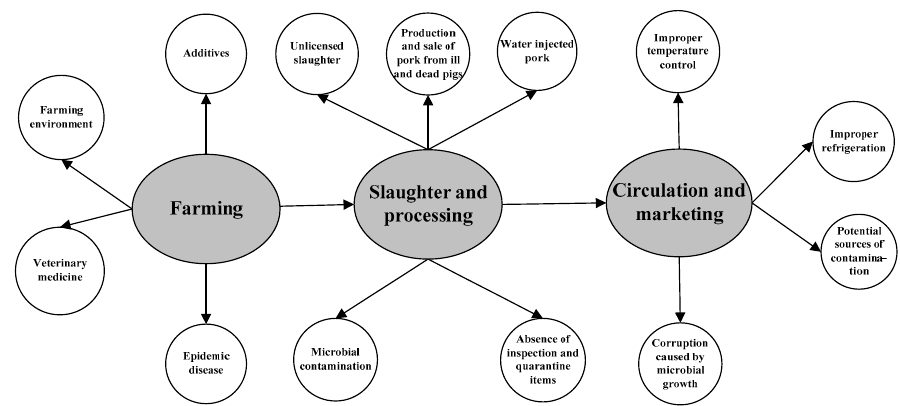
Figure 1. Specific safety risks in the major processes of the pork supply